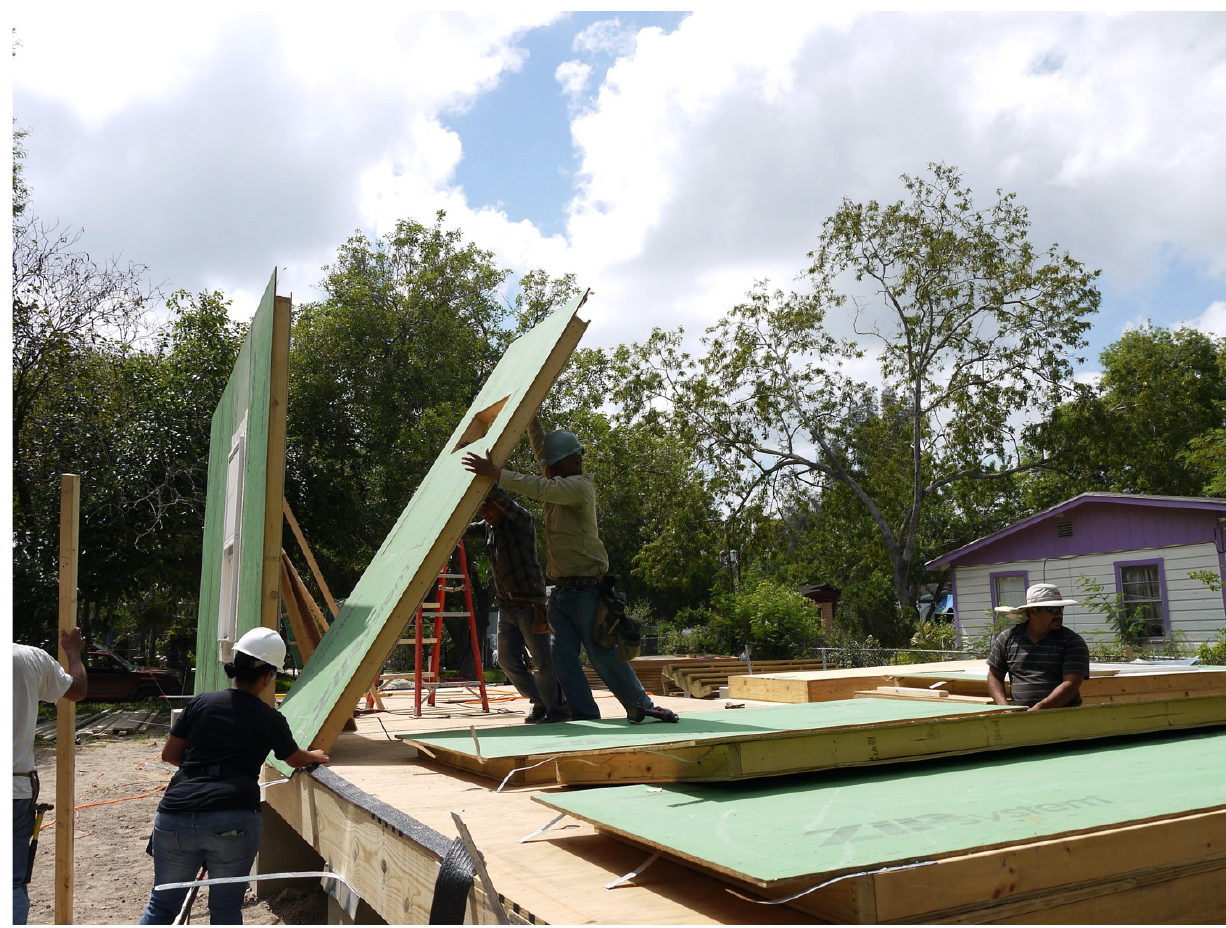
Figure 1. Photograph showing the installation of SIPs in the core of a RAPIDO prototype home. Source: bcWORKSHOP